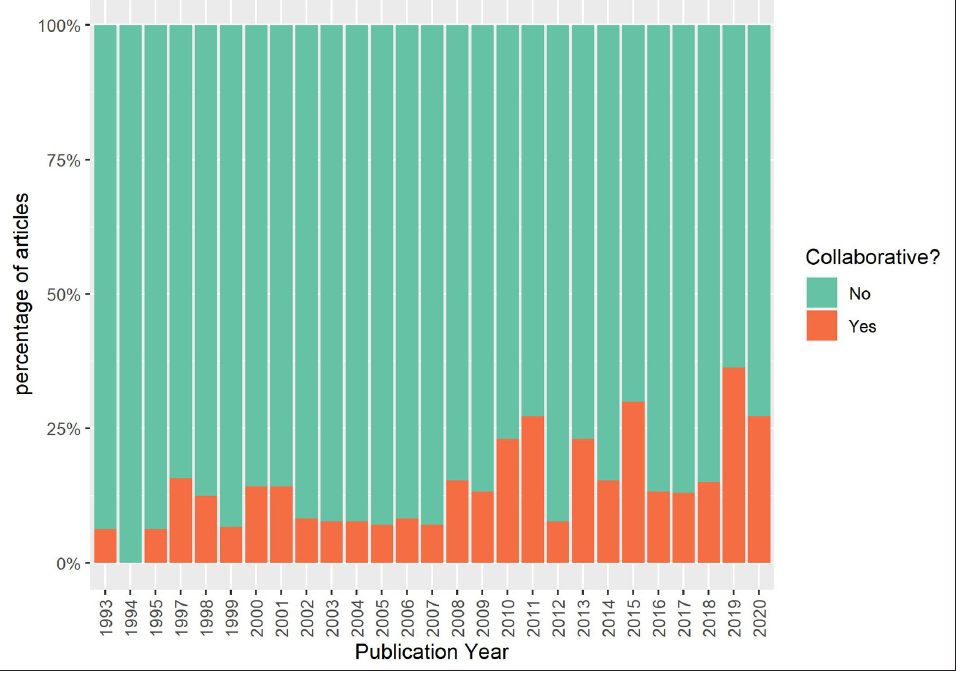
Figure 3: Percentage of single and multi-author articles within TRAC publications published per